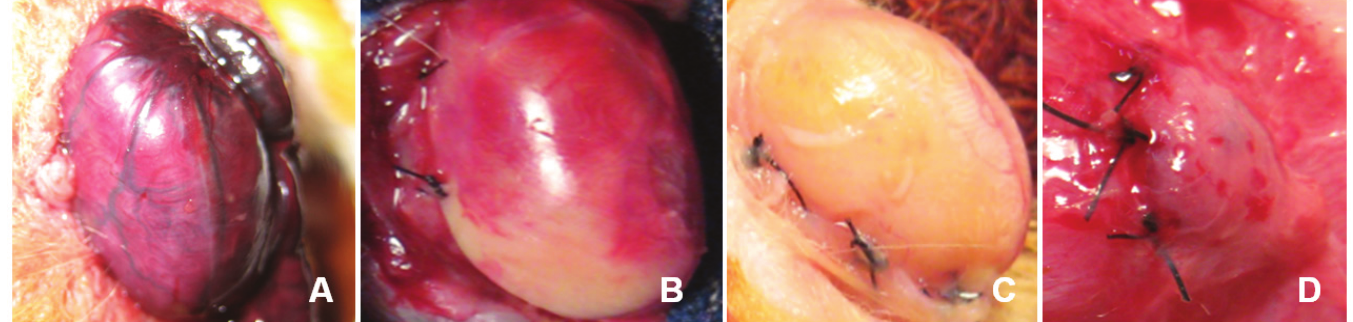
FIGURE 2 - Photographs A, B, C and D show the macroscopic aspects of the twisted left testes of the experimental subgroups at one, five, ten and 90 days, respectively: A ) Dark red color due to the ischemia, B ) Partially white-yellow color, C ) Completely white-yellow color, D ) Hypotrophy and normal